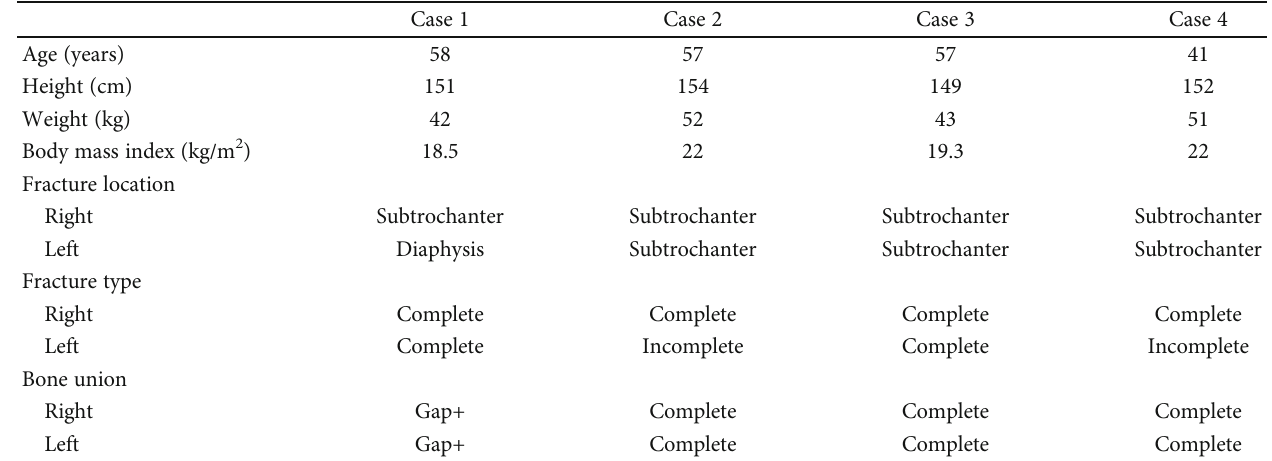
Table 2: Clinical features of each